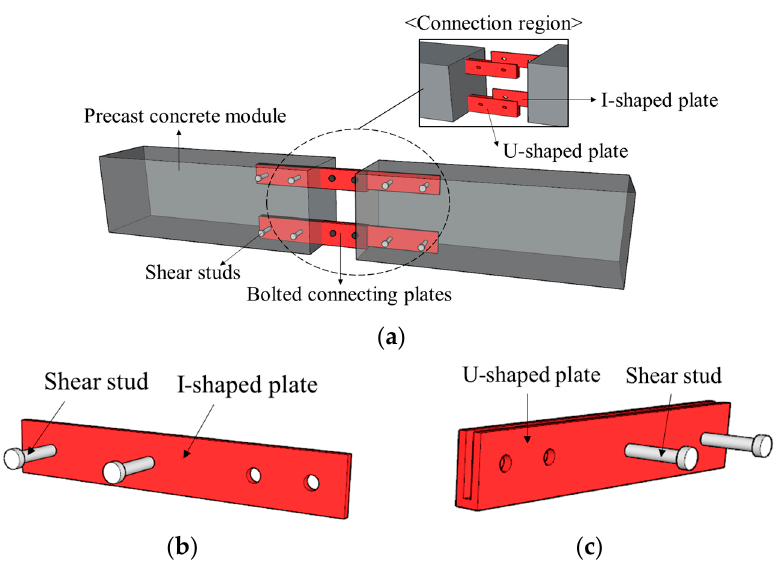
Figure 2. Schematic of the proposed precast concrete modular beam using a bolted connecting plate: ( a ) front view; ( b ) I-shaped plate; ( c ) U-shaped plate.